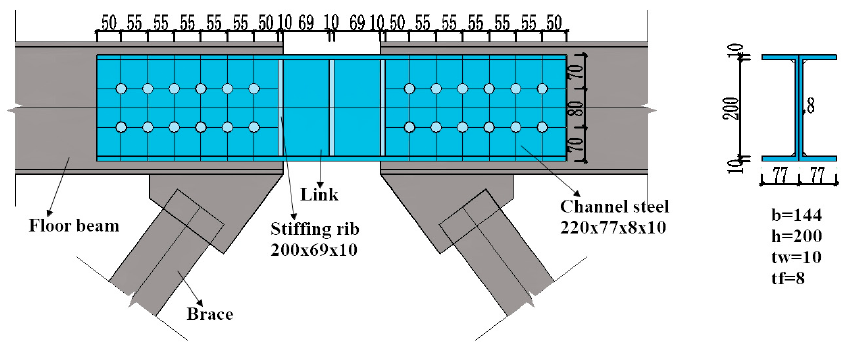
Figure 1. Detail drawing of test specimen.